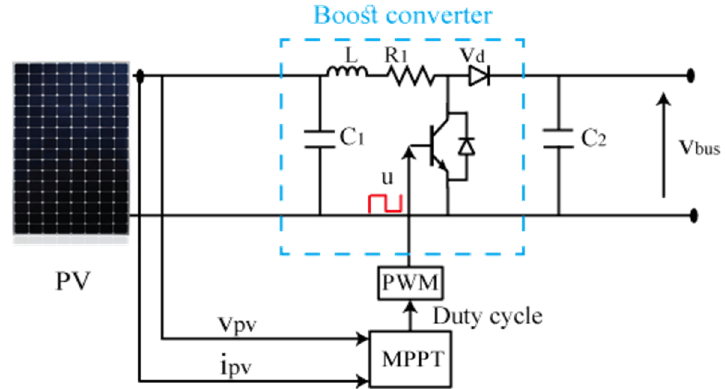
Figure 3. Photovoltaic system.